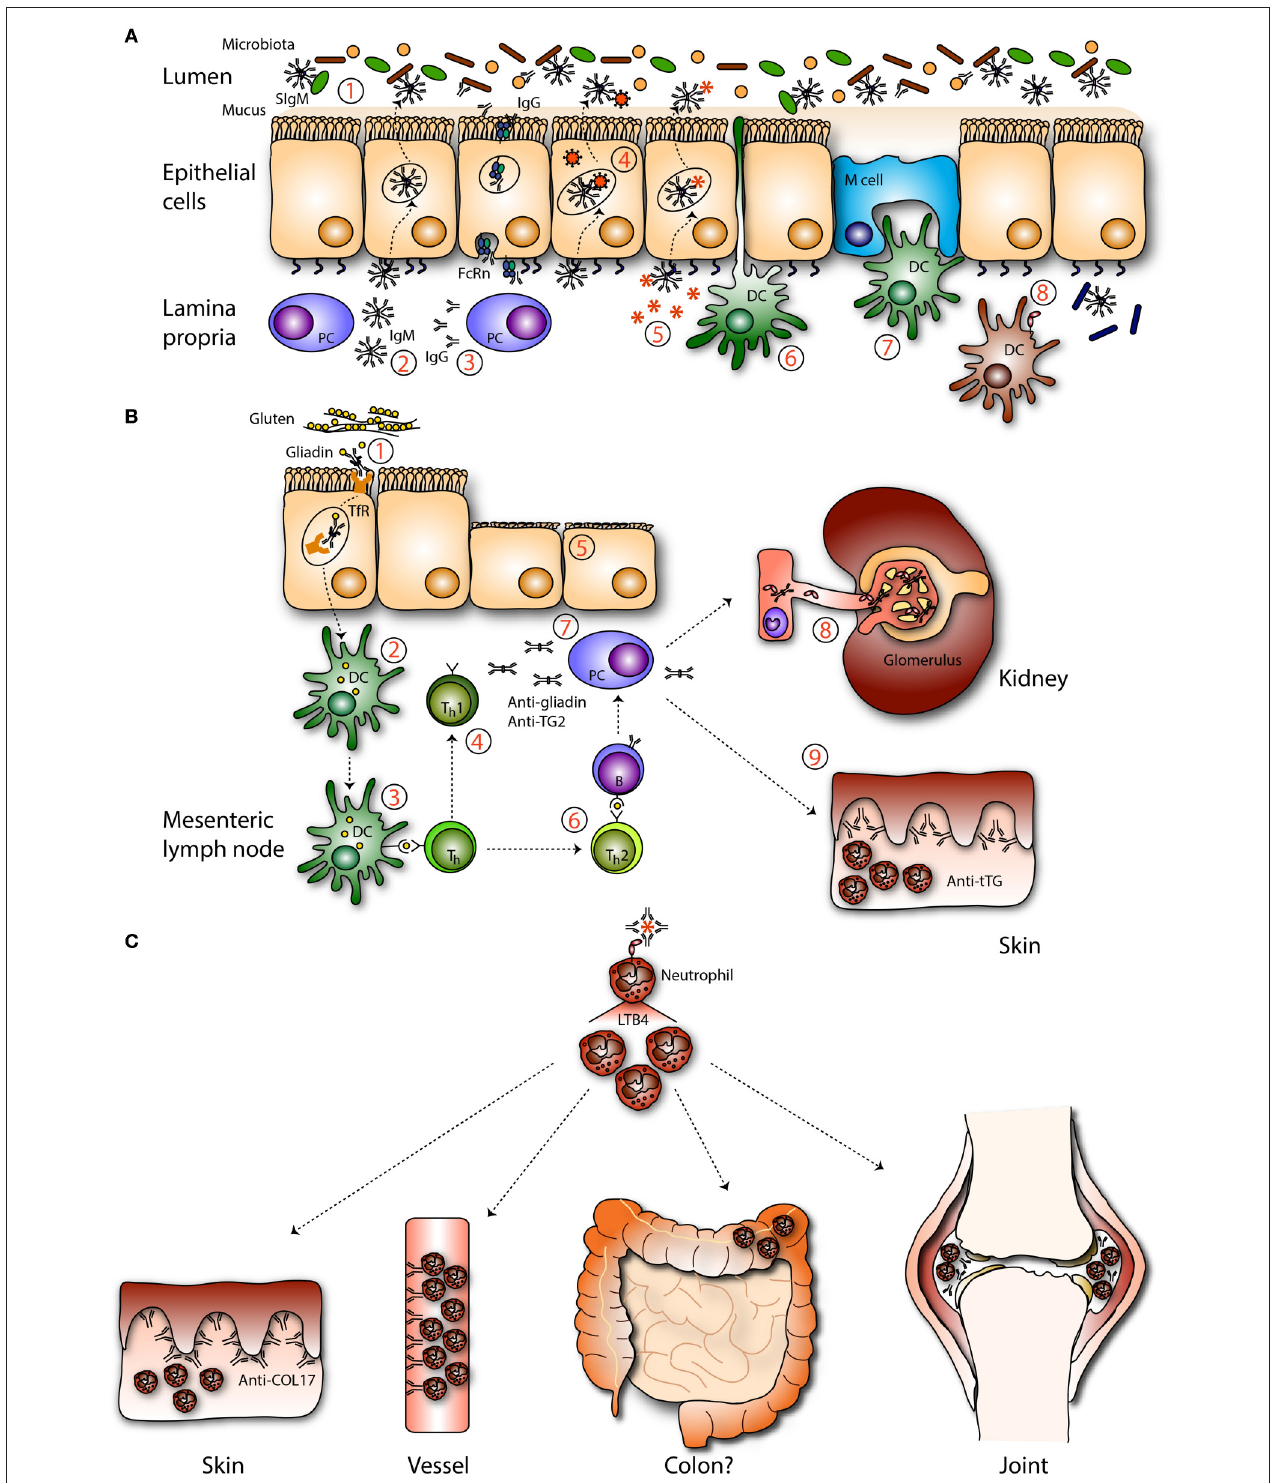
FIGURE 3 | Mucosal IgA in pathogenesis. (A) IgA deficiency. In absence of IgA the intestinal microbiota is (1) less diverse and unbalanced. (2) IgM, and (3) IgG can be transported across the epithelium by associating with the pIgR or the neonatal Fc receptor (FcRn), respectively, to compensate IgA loss. Theoretically, IgM may be able to (4) neutralize viruses and (5) exclude infiltrated antigens. Sub epithelial DCs are not described to (6) sample IgM coated bacteria.